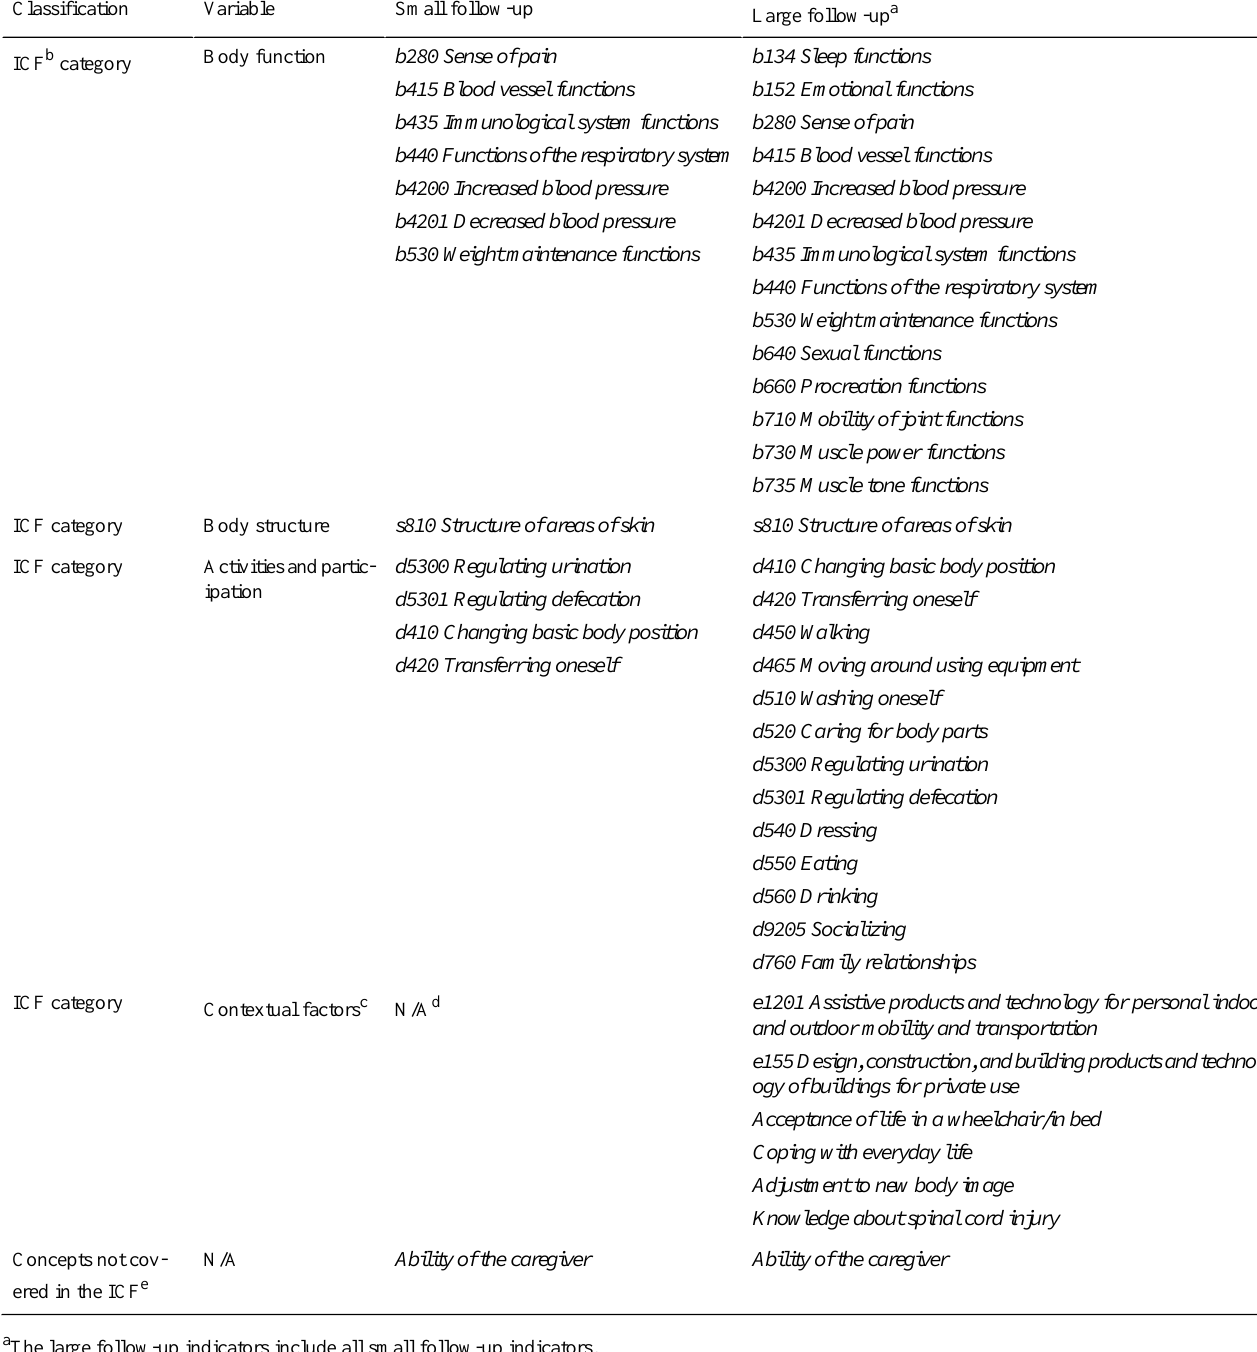
Large follow-up a Small